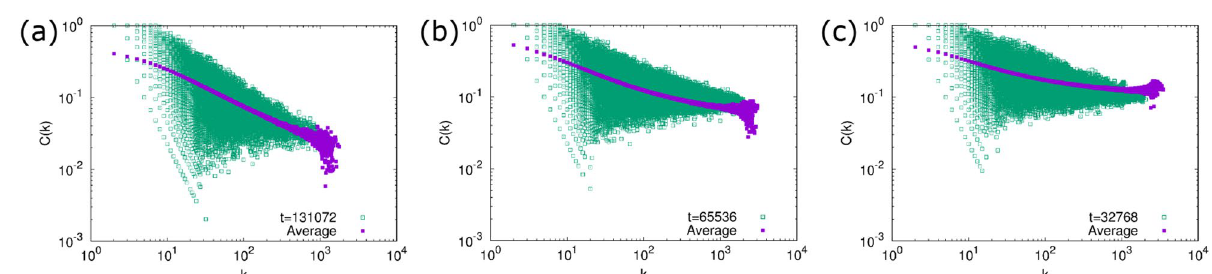
3 √ 2 . Open squares are the result for a single trial and 1 , ( b ) δ δ 2 , and ( c ) = (cid:31) = =